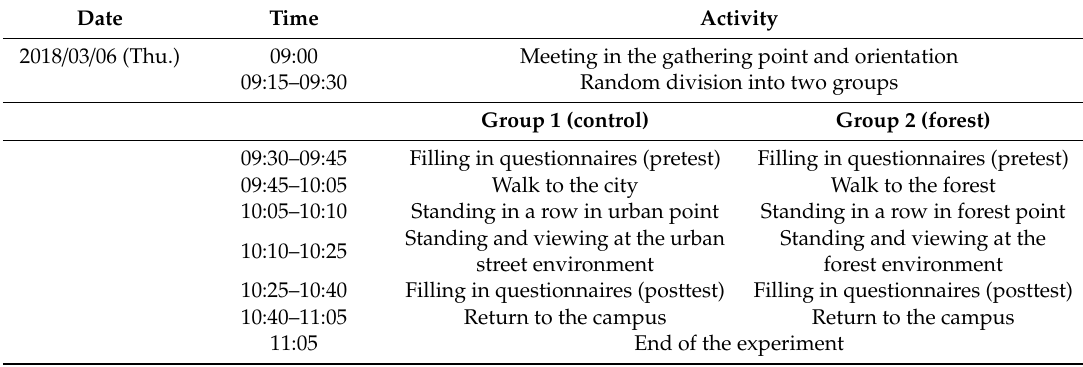
Table 2. Procedure followed during the